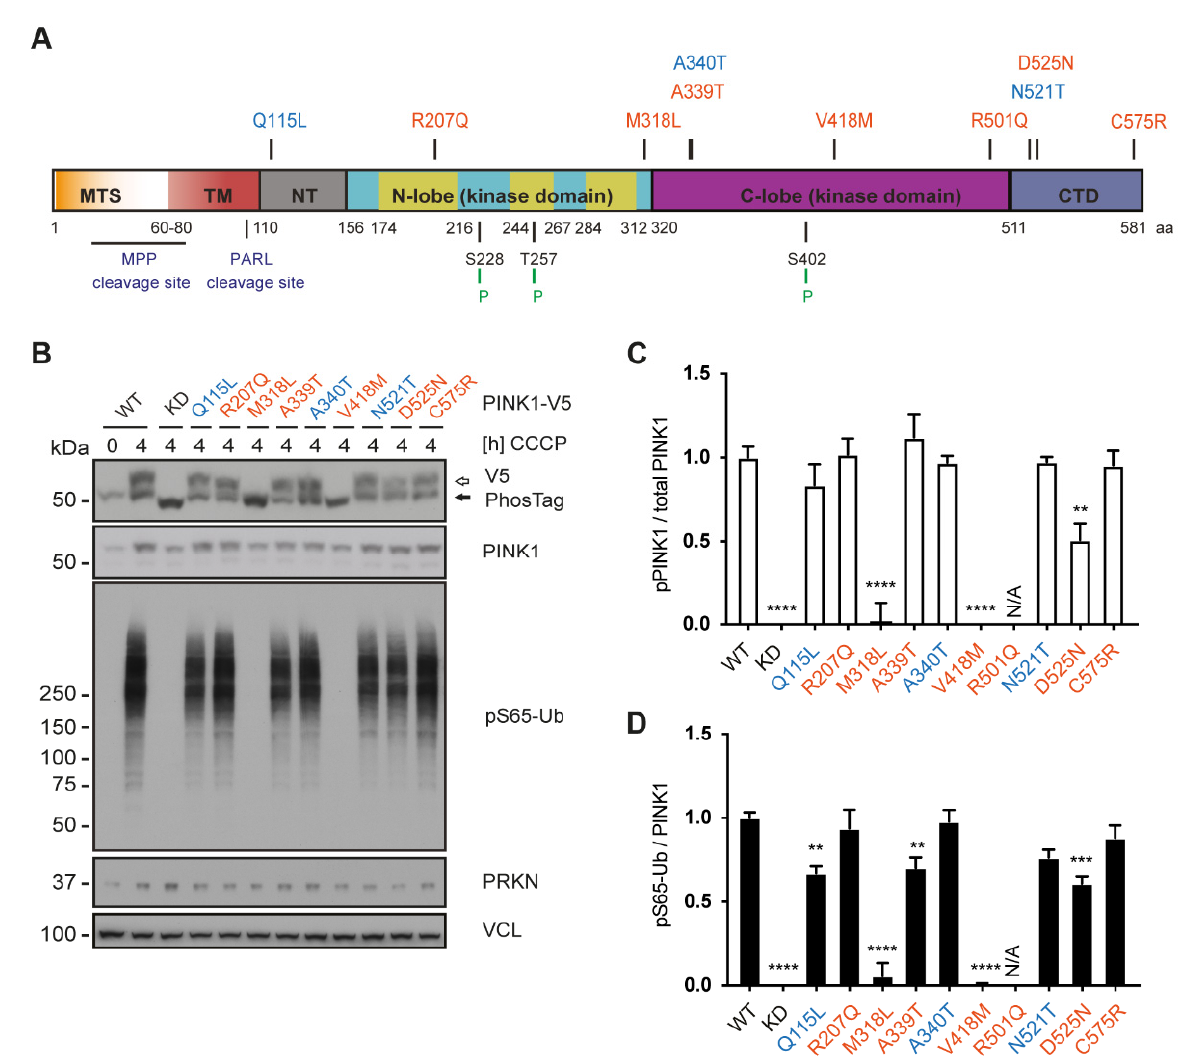
Figure 4. Functional analysis of genetic PINK1 variants. ( A ) Organization of PINK1 protein with the location of investigated SNVs. Protein domains are drawn to scale and color-coded (orange: mitochondrial targeting sequence, red: transmembrane domain, grey: N-terminal, blue/purple: N-lobe/C-lobe kinase domains with insertion loops highlighted in yellow, dark blue: C-terminal domain). Protease cleavage sites and auto-phosphorylation sites labelled below. Investigated PINK1 variants are listed at the top: rare variants in red, and frequent PINK1 SNVs in blue. ( B ) HEK293E PINK1 KO cells were transfected with either PINK1-V5/6xHis WT, kinase-dead (KD) or the genetic PINK1 variants and left untreated or treated with CCCP, as indicated. Standard and phostag electrophoresis were performed and Western blots prepared. Blots were probed with V5 and PINK1 antibodies to assess the levels of total and phosphorylated PINK1 kinase. pS65-Ub antibodies were used to determine the amount of PINK1 product. PRKN levels were unaffected by transfection of PINK1 variants. VCL was used as loading control. ( C , D ) Quantification of Western blots shows normalized values for phosphorylated PINK1 protein over total PINK1 protein ( C ) and pS65-Ub over total PINK1 ( D ) for each variant. Data from at least four independent experiments was normalized to WT and KD, set to 1 and 0, and is shown as mean ± SEM. As PINK1 R501Q was not stabilized upon CCCP, it was omitted from the quantification. Statistical analysis was performed using one-way ANOVA with Dunnett’s post hoc test to correct for multiple testing (** p < 0.005, *** p < 0.0005, **** p < 0.0001, N/A not